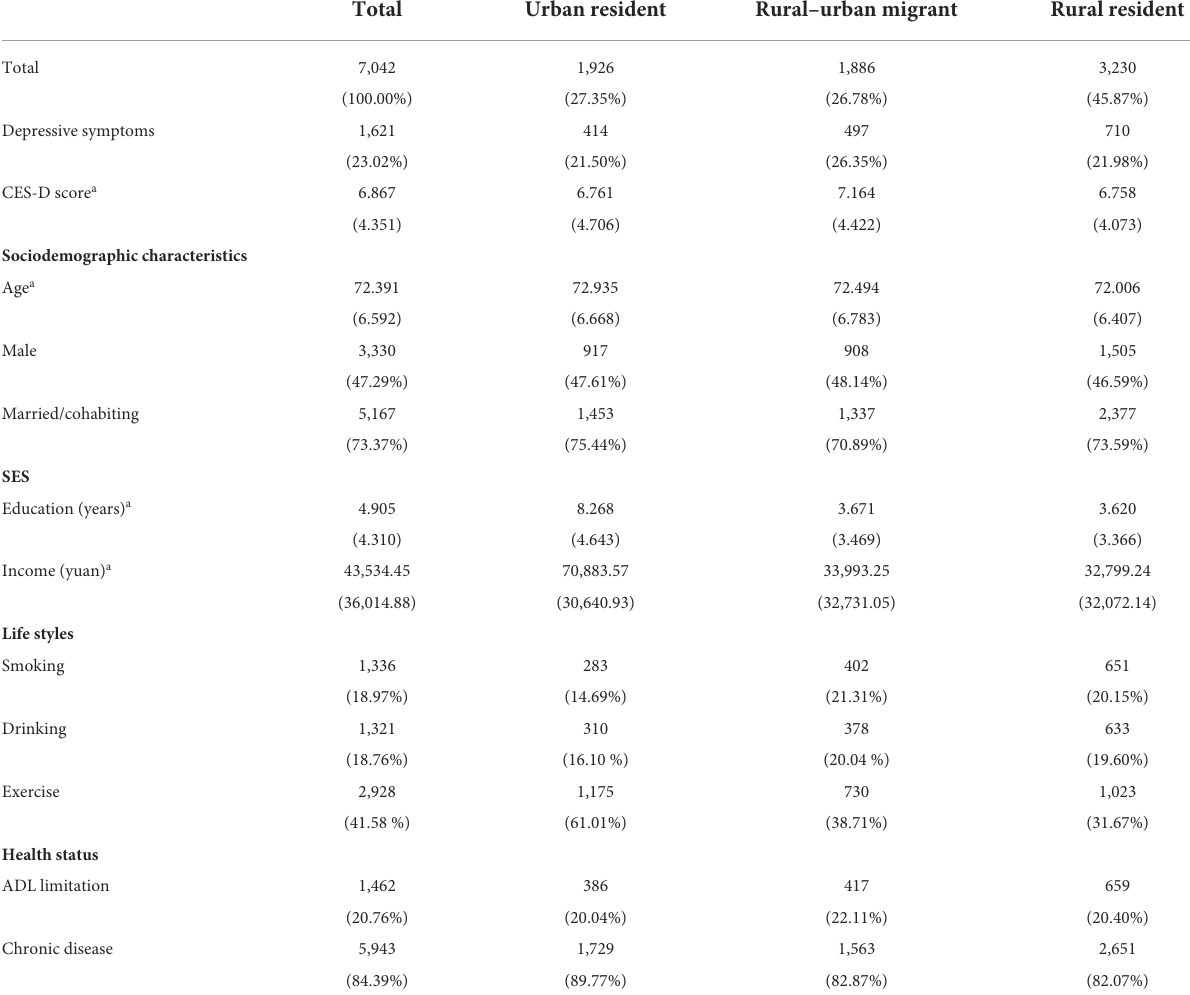
TABLE 2 Descriptive characteristics of study participants from CLHLS 2018